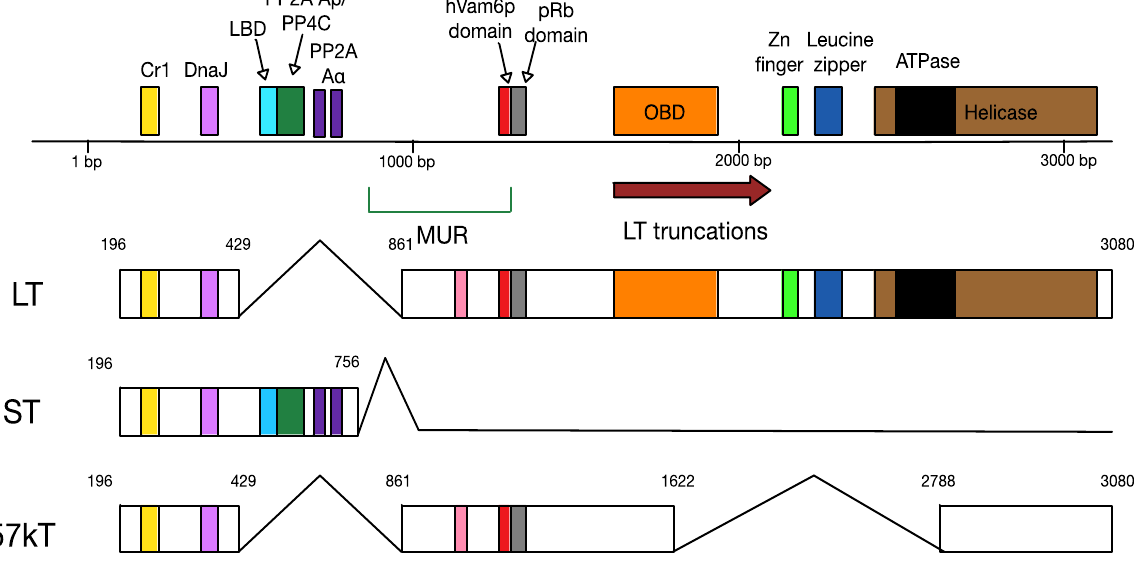
Figure 4. Mapping of the multiply-spliced MCPyV T antigens. The three T antigens are LT, ST and 57kT. All three encode CR1 (yellow, LXXLL) and DnaJ (lilac, HPDKGG) domains. ST also contains two PP2A Aα binding sites (R7 and L142), a PP2A Aβ/PP4C binding site (amino acids 97–111) and an large T-stabilisation domain (LSD, amino acids 91–95). LT shares the pRb binding domain with 57kT; in addition, it has unique origin binding (OBD), zinc finger, leucine zipper, ATPase and helicase domains. The MCPyV-unique region (MUR) of LT contains the hVam6p binding